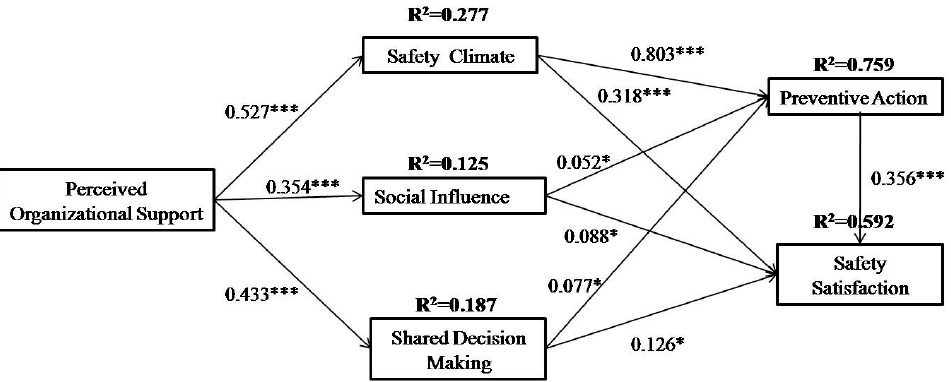
Figure 2. Final proposed model. *** p < 0.001; * p < 0.05. Table 4. Summary of hypotheses validated results.